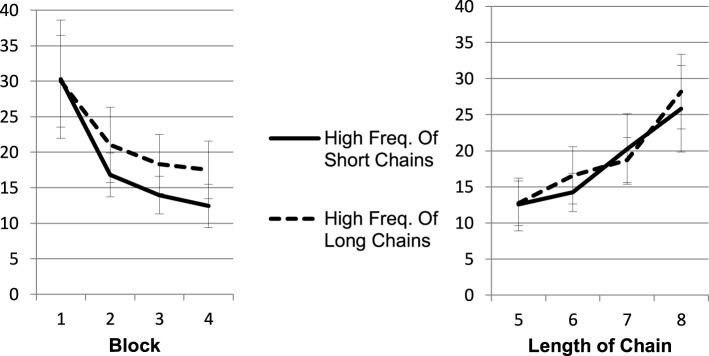
Average exploration time depending on the frequency of the chain types (short chains frequently vs. long chains frequently). The left panel depicts that participants in the condition with high frequency of long chains on average needed more time for exploration. As the right panel pictures, this effect is exclusively explained by the larger amount of longer chains contributing to the average. There are no differences between the length-set groups in the speed of exploring the chains of different lengths.